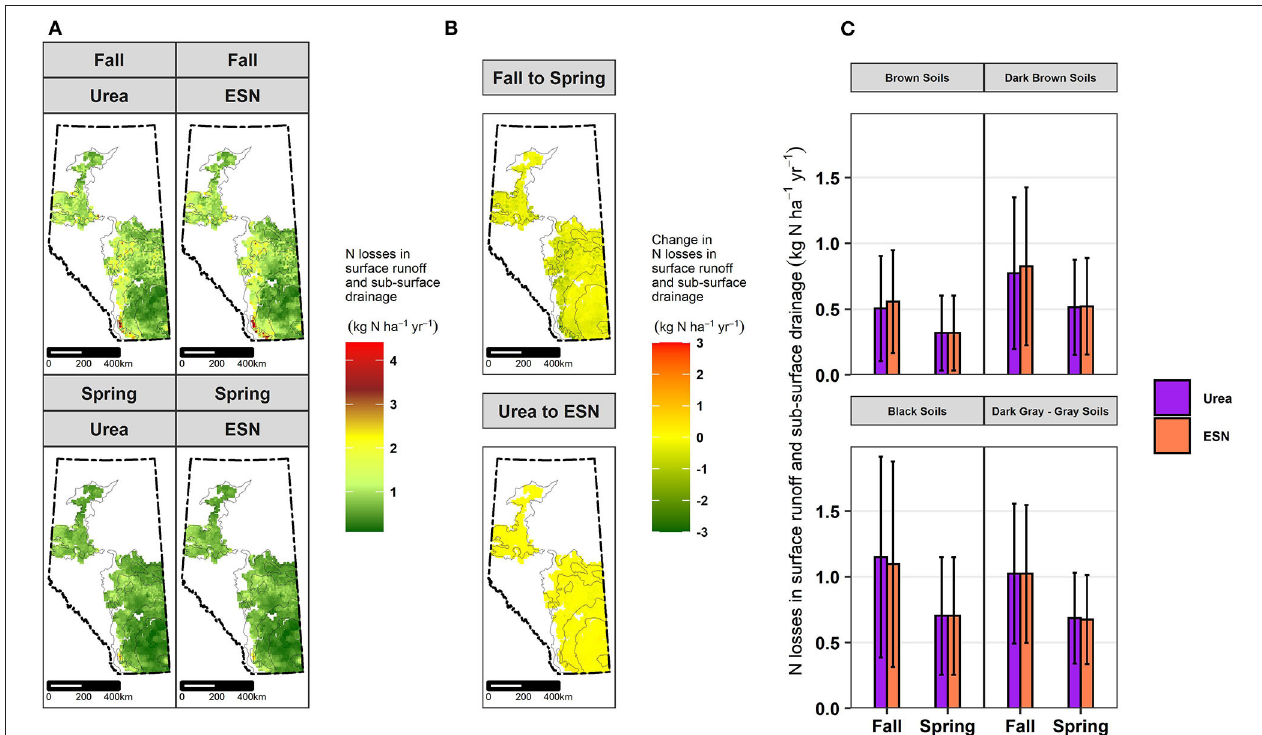
FIGURE 12 | (A) Spatial distribution of modeled annual (January 1–December 31) nitrogen losses in surface runoff and sub-surface drainage averaged over the simulation period (2011–2015) for each township for each of the fall and spring banded urea and ESN applications across mid-slope landforms of Alberta under simulated barley cultivation. (B) Spatial distribution of differences in modeled annual nitrogen losses in surface runoff and sub-surface drainage for fall vs. spring and urea vs. ESN applications averaged over the simulation period (2011–2015) for each township across mid-slope landforms of Alberta under simulated barley cultivation. A positive change represents an increase in nitrogen losses in surface runoff and sub-surface drainage for a change from fall to spring or from urea to ESN and vice versa. The white areas on the map were not modeled based on the selection criteria as described in section Methodology and Model Inputs. The thick dashed lines on the maps represent Alberta’s provincial boundary, and the thin black lines within the maps demarcate soil group areas. (C) Soil group-wise averages of modeled annual nitrogen losses in surface runoff and sub-surface drainage for fall vs. spring banding and urea vs. ESN applications averaged over the simulation period (2011–2015) for all the townships in each soil group area across mid-slope landforms of Alberta under simulated barley cultivation. Error bars represent standard deviations illustrating spatiotemporal variations in modeled annual nitrogen losses in surface runoff and sub-surface drainage within each soil group